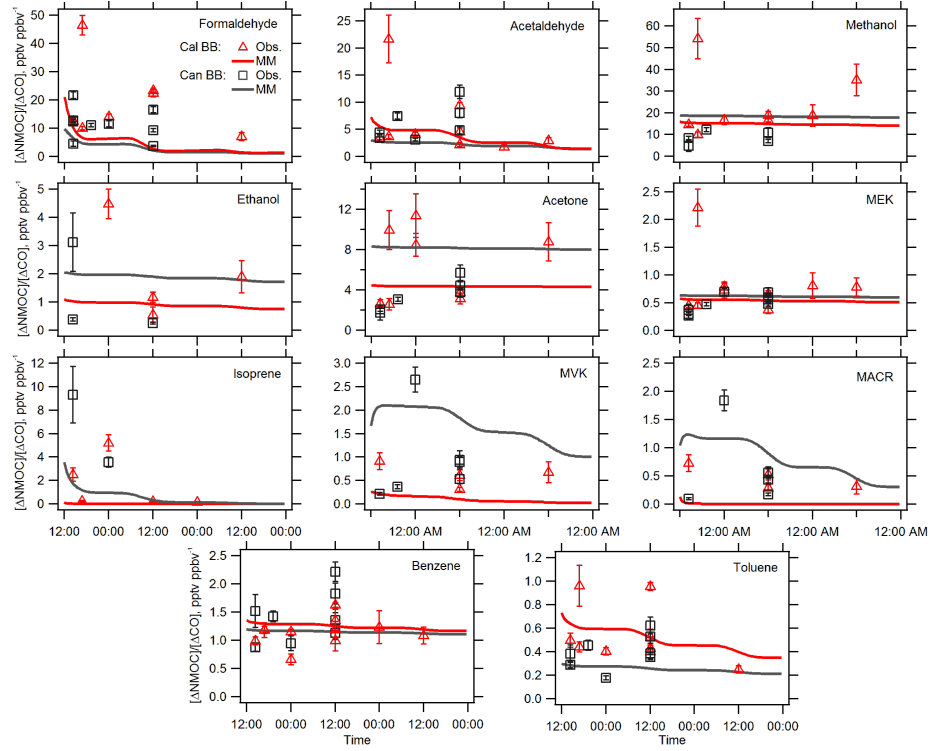
Fig. 12. Plots of Master Mechanism (MM) modeled and observed NEMRs to CO for 11 NMOCs. Points are the ARCTAS-observed NEMRs to CO for BB plumes estimated to be aged 3days or less, as measured by DFGAS (formaldehyde) and TOGA (all others), with error bars as described for Fig.